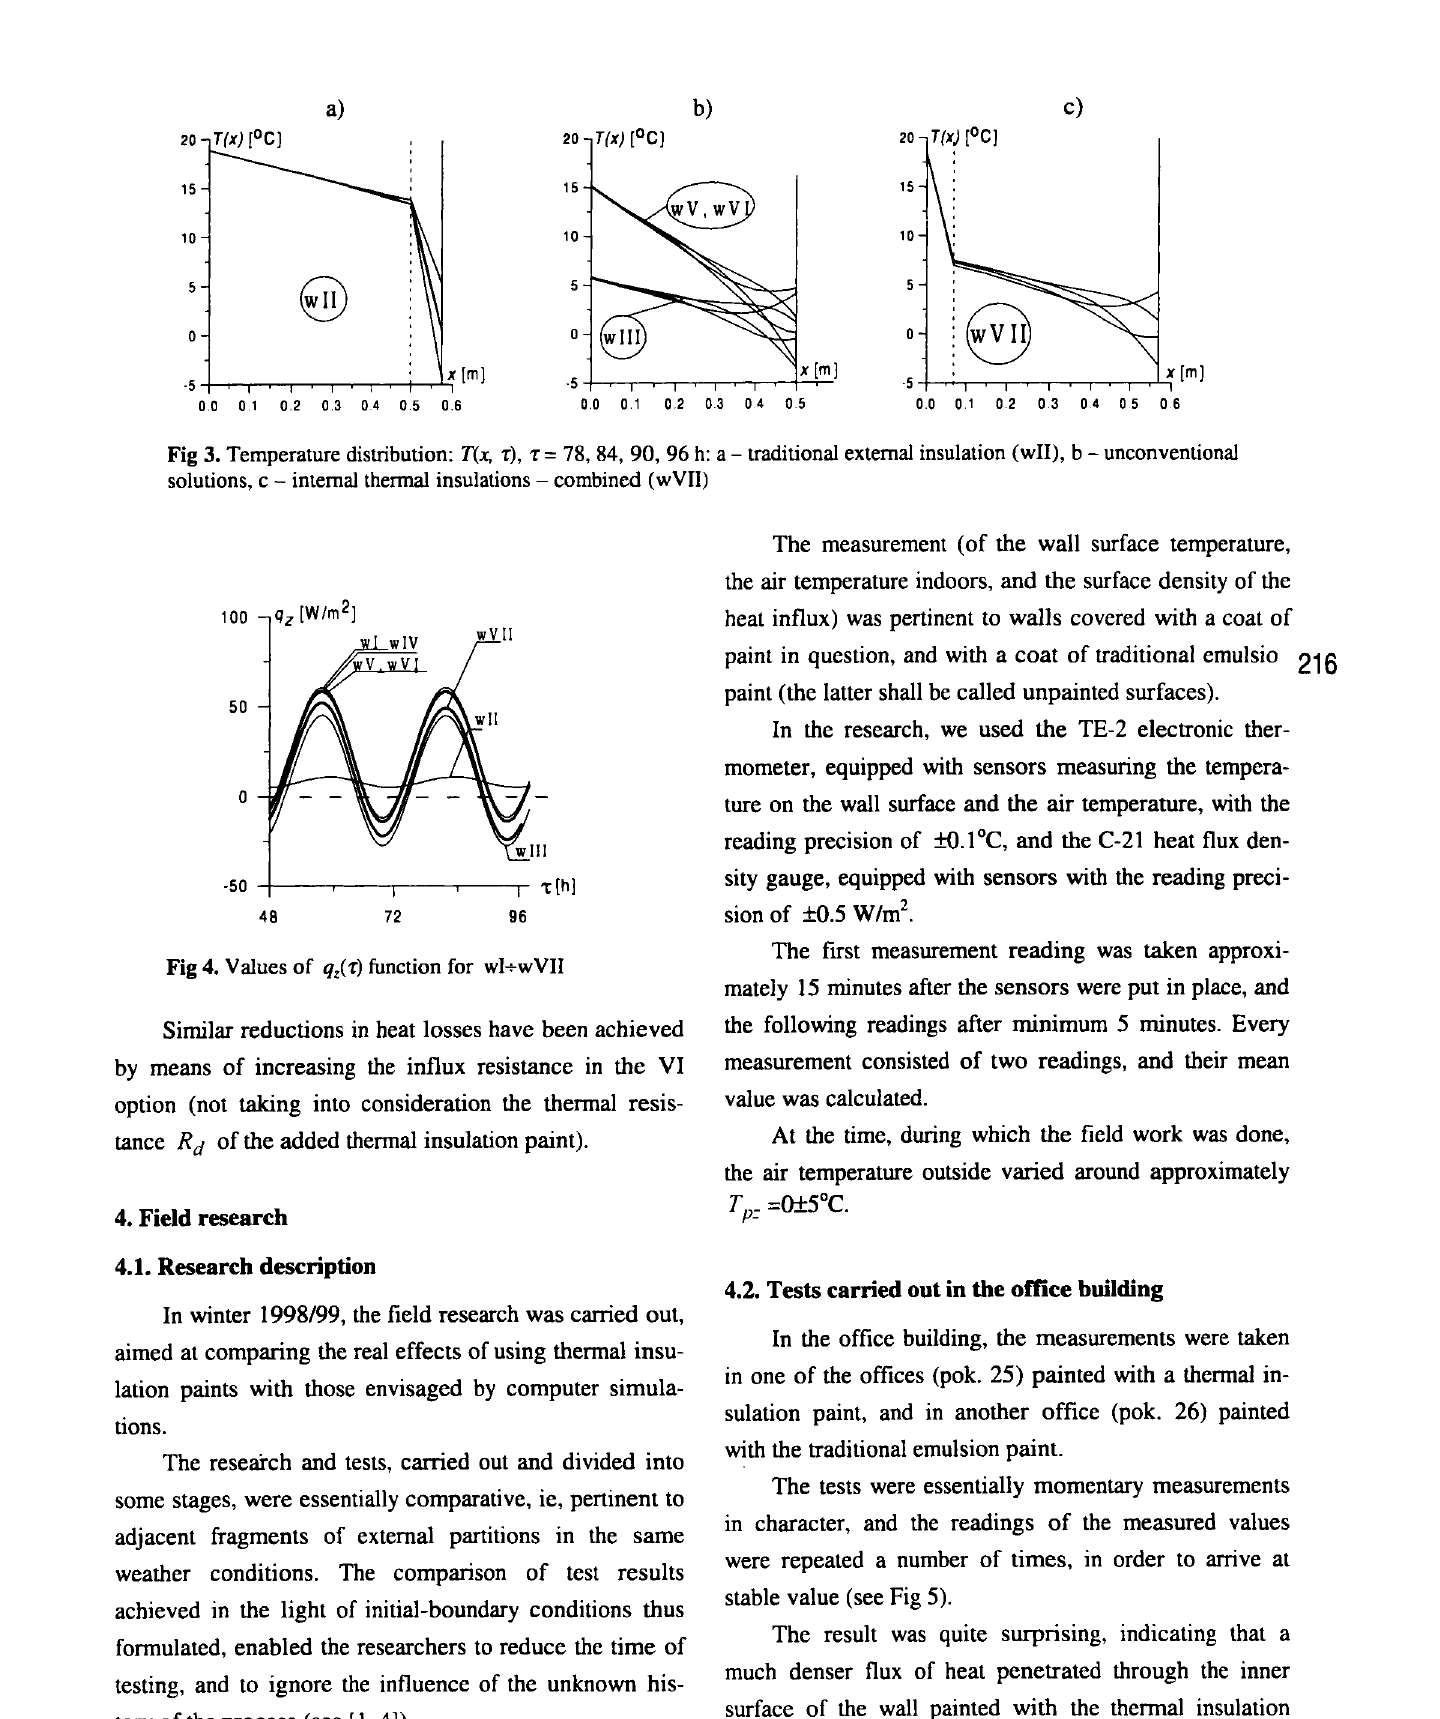
Fig 3. Temperature distribution: T(x, r), r = 78, 84, 90, 96 h: a- traditional external insulation (wii), b- unconventional